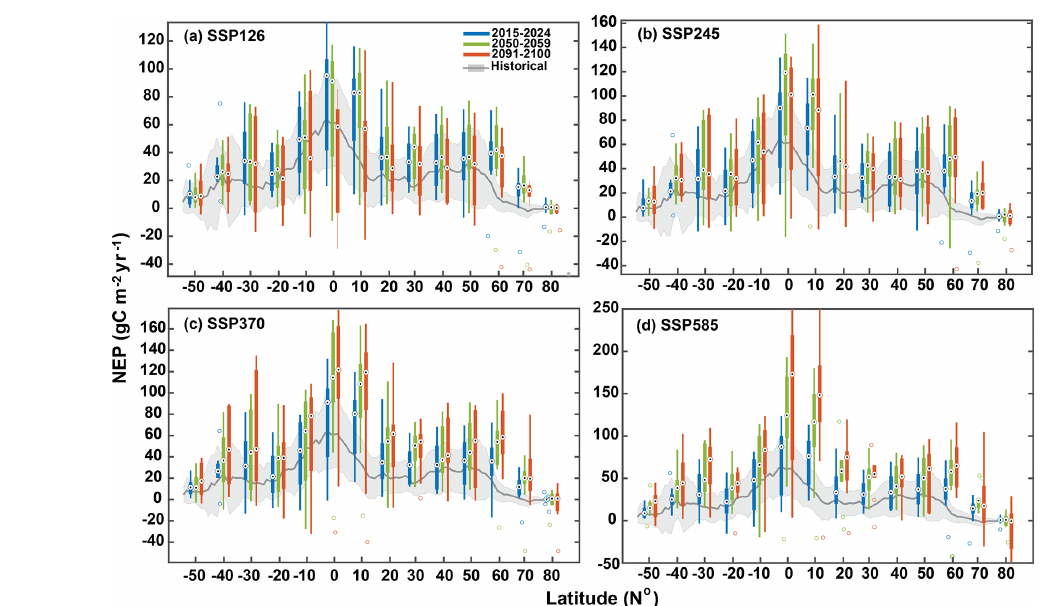
Figure 4. Latitudinal distributions of NEP in the historical period and under different future scenarios. The gray lines with bands are the historical multi-model mean and uncertainties in NEP. The boxplots are the future NEP distributed in each 10 ◦ bin between 60 ◦ S